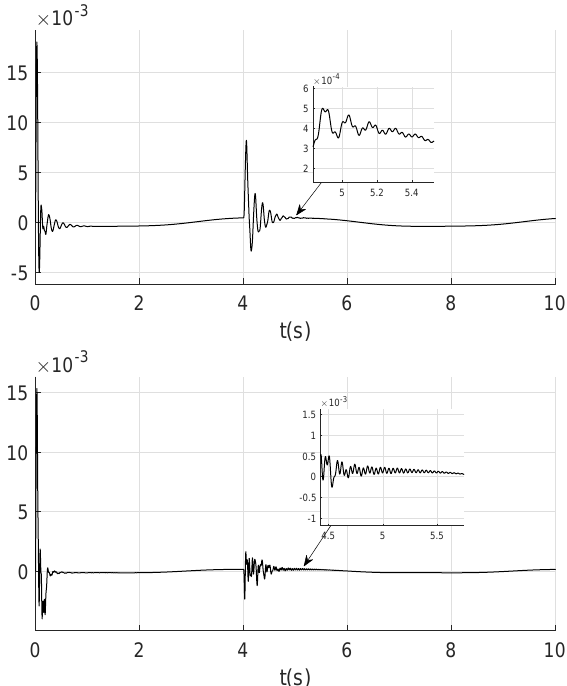
Figure 10. Curve with hybrid control tracking error under the influence of